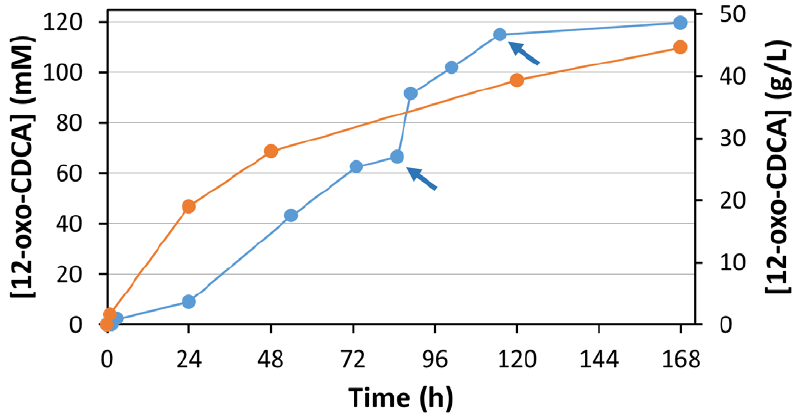
Figure 5. Bioconversion time-courses employing El 12 α -HSDH (0.013 mg / mL–0.8 U / mL with CA as substrate) coupled with: (blue line) Mt Lac (0.34 mg / mL–1.8 U / mL), syringaldazine (50 µ M) and 10% DMSO; (orange line) ADH420 (0.05 mg / mL–0.06 U / mL) and 15% (v / v) acetone. All reactions were carried out in presence of 0.5 mM NAD + in 100 mM KPi bu ff er, pH 7.2 at 25 ◦ C. The addition of 7 mg